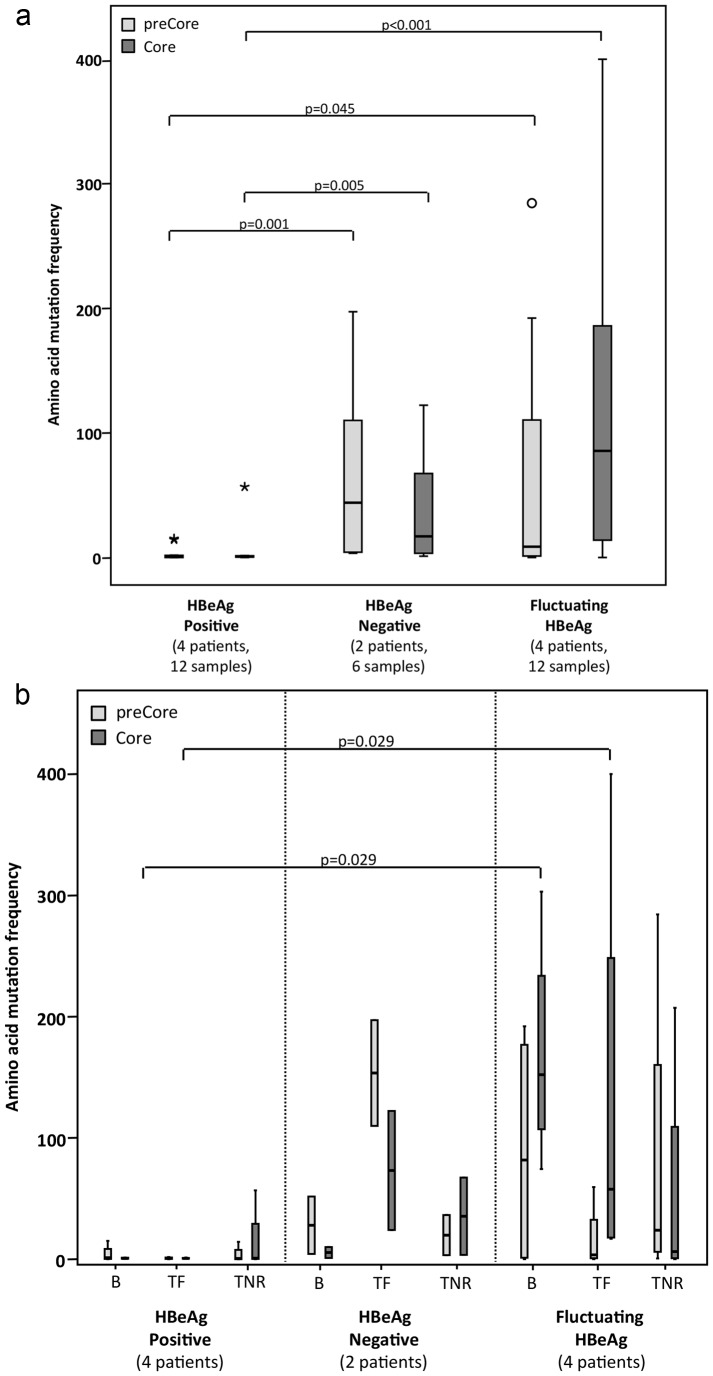
Distribution of mutated amino acids in the preCore and Core regions (a) in patients grouped by HBeAg evolution and (b) splitting into HBeAg evolution and the three time points: baseline (B), treatment-free (TF) and treatment-nonresponse (TNR).